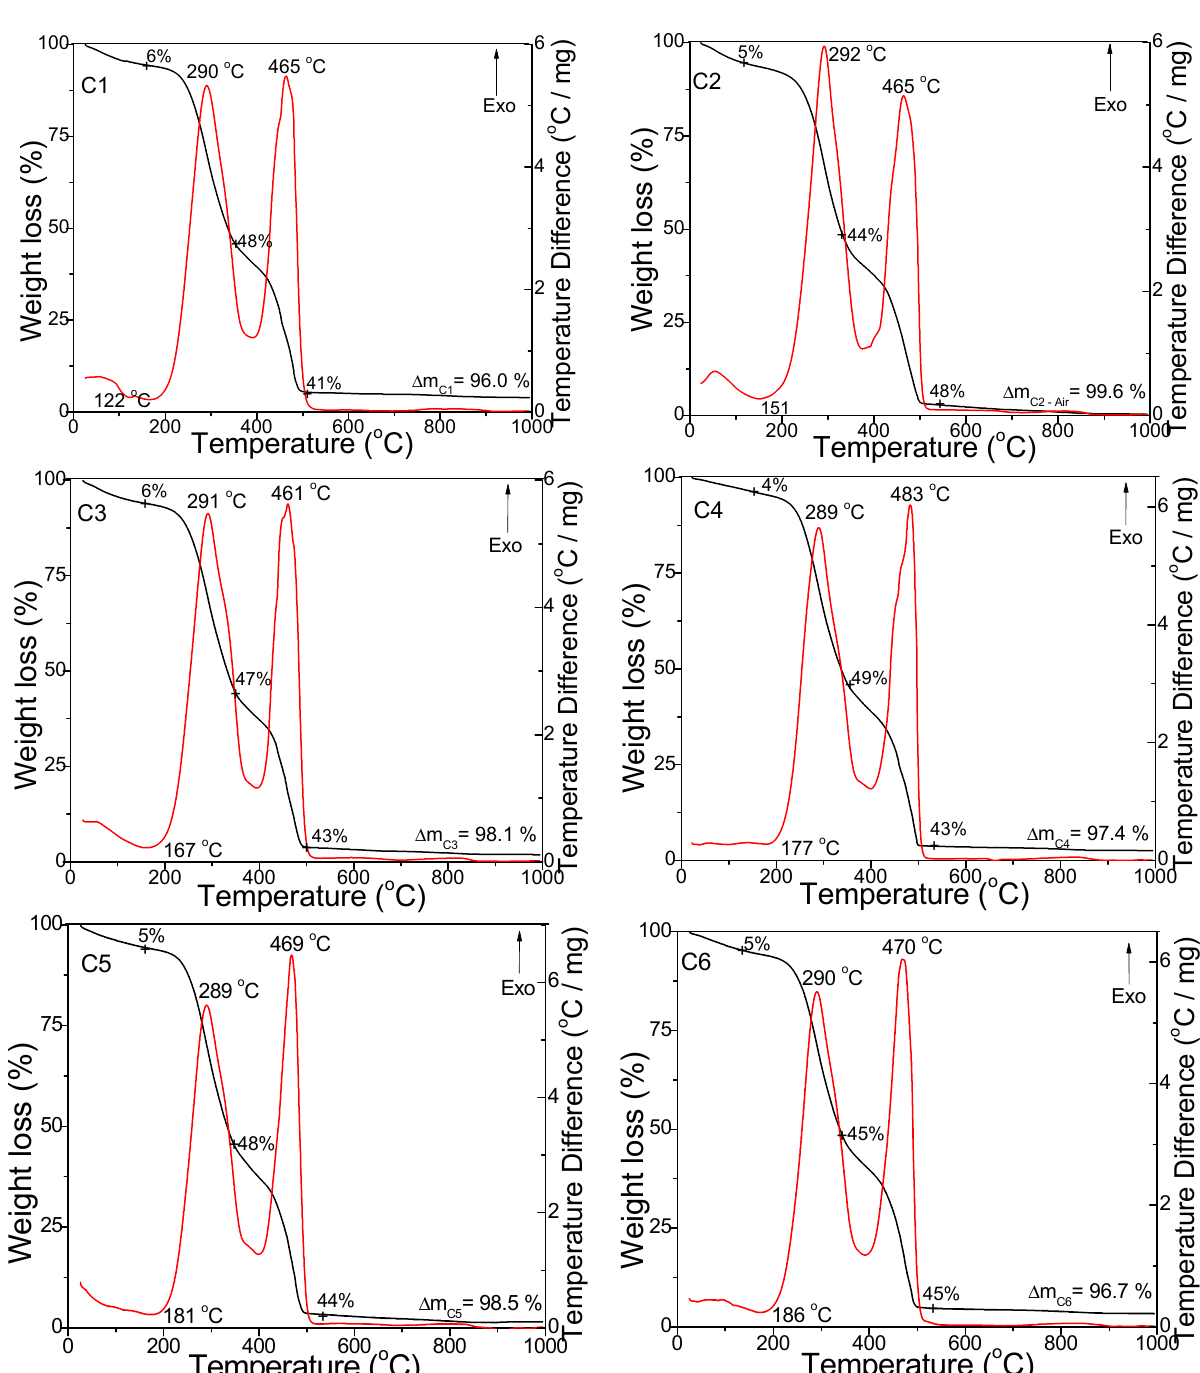
Figure 1. TG (black line) and DTA (red line) curves of the coffee samples under air atmosphere.